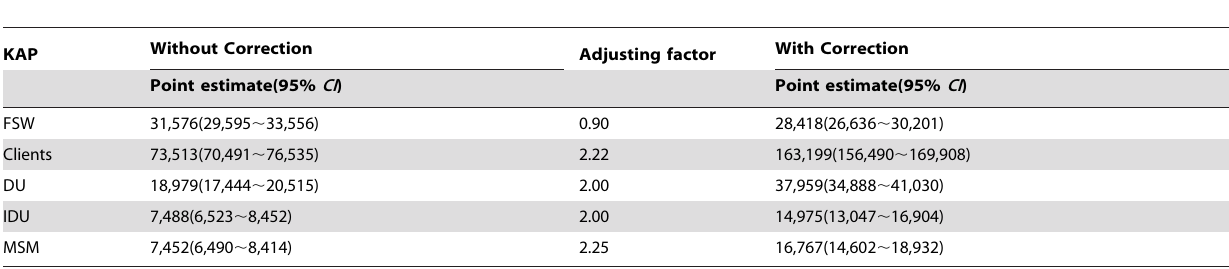
Table 5. The estimated number of people in KAP, Chongqing, China (2011).